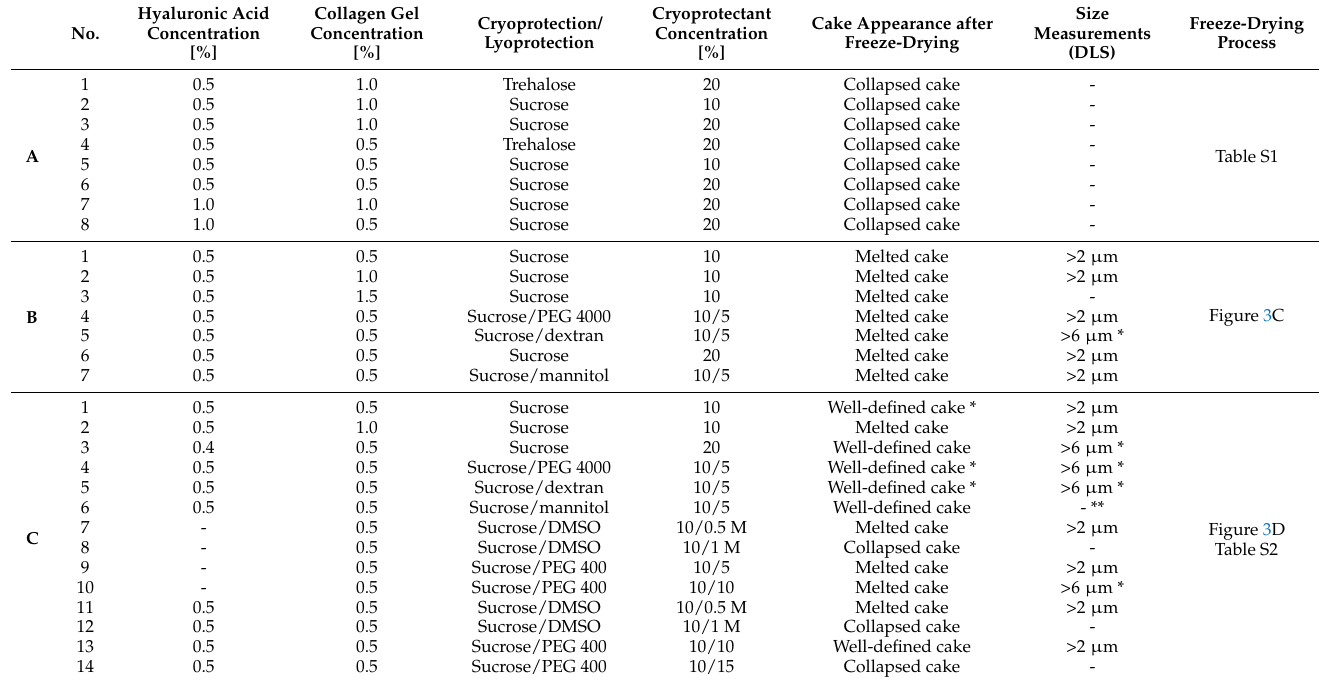
Table 1. Summary of the formulations evaluated using various hyaluronic acid and collagen concen- trations, as well as different types of cryo-/lyoprotectants.